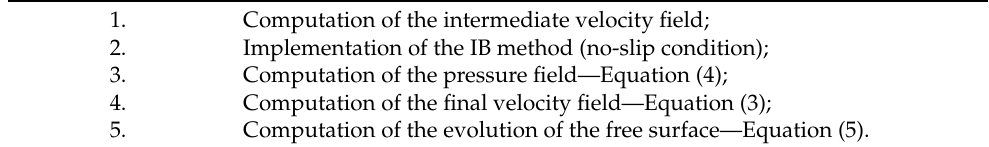
Table 1. The main stages of the